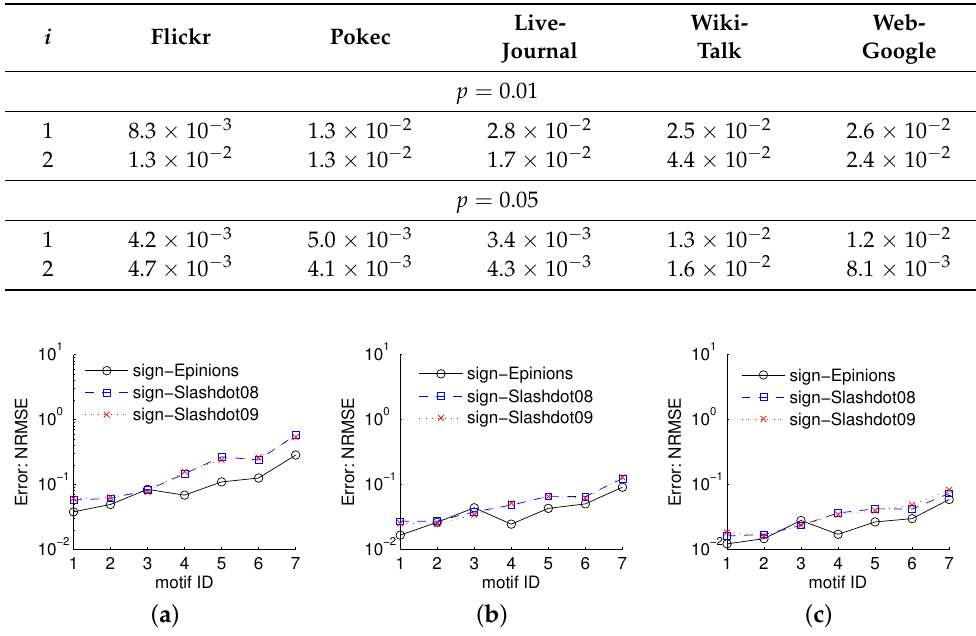
( 3 ) Figure 8. NRMSEs of ˆ n , the estimates of three-node signed and undirected motif frequencies for i p = 0.01, p = 0.05, and p = 0.1, respectively. Sign-Epinions, sign-Slashdot08, and sign-Slashdot09 have 1.72 × 10 8 , 6.72 × 10 7 , and 7.25 × 10 7 three-node CIS, respectively: ( a ) p = 0.01; ( b ) p = 0.05; ( c ) p = 0.1.